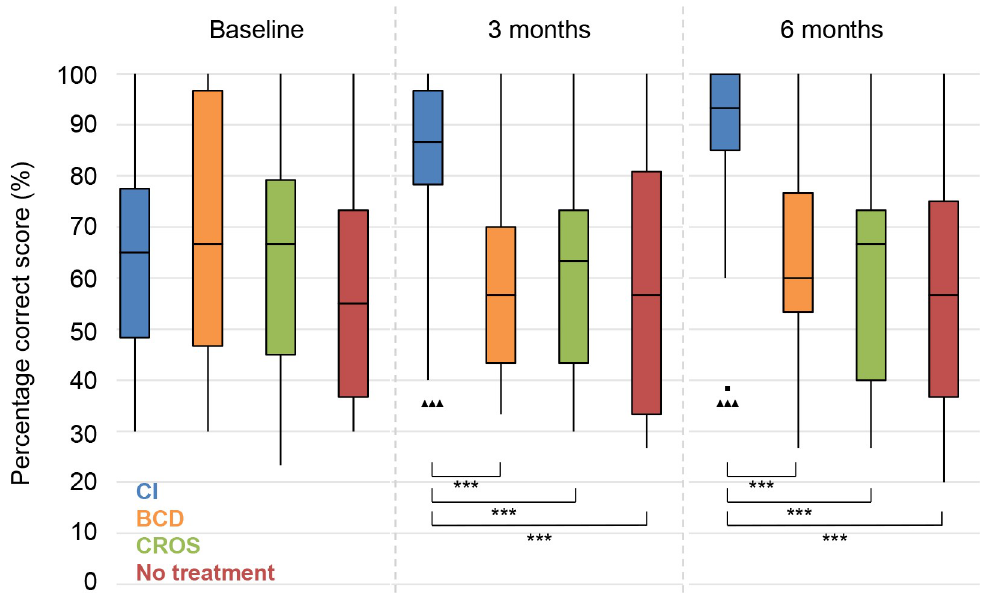
Fig 7. Sound localisation. Sound localisation as a percentage correct score (%) for configuration 60˚ angle between 3 loudspeakers (chance level: 33.3%). Statistical difference compared to baseline. ▲▲▲ = p < 0.001; ▲▲ = p < 0.01; ▲ = p < 0.05. Statistical difference compared to 3 months follow-up. ■■■ = p < 0.001; ■■ = p < 0.01; ■ = p < 0.05. Statistical difference between groups at same follow-up moment. ��� = p < 0.001; �� = p < 0.01; � = p <